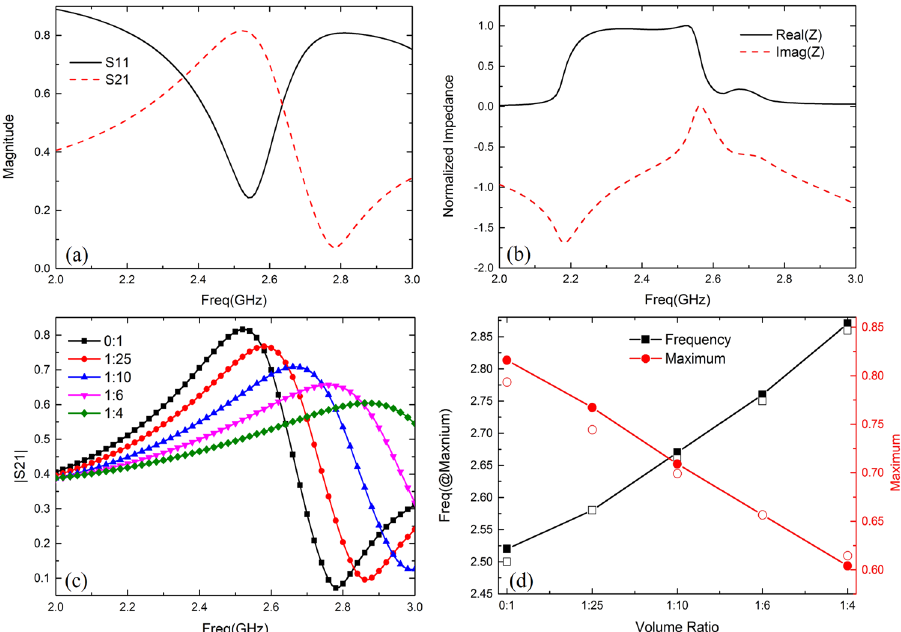
Figure 2. ( a ) Simulated transmission and reflection for filled ultra-pure water in dB. ( b ) The normalized impedance for filled ultra-pure water. ( c ) Simulated transmissions for state 1. ( d ) Simulated (solid) and measured (open) maximum magnitudes and their corresponding resonant frequencies vary with volume ratio for state